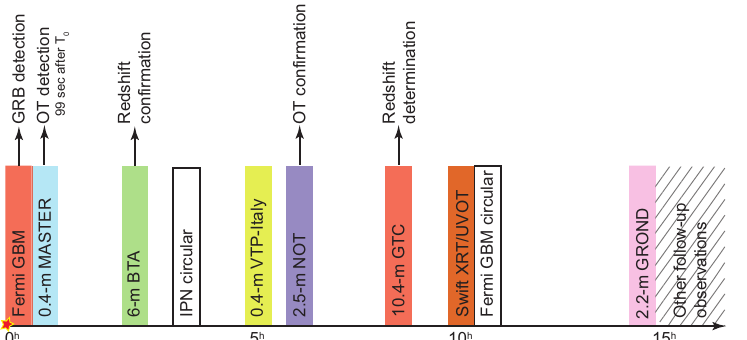
Figure 3. Sample GRB observation timeline. The figure shows the approximate time of observations obtained for GRB 140801A by the different facilities. For IPN and Fermi GBM, the time of GCN circular publication is shown. Adopted from Figure 2 in